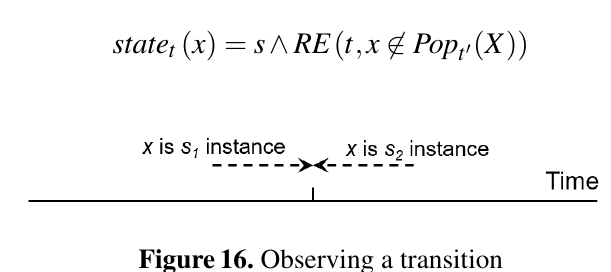
Figure 16. Observing a transition